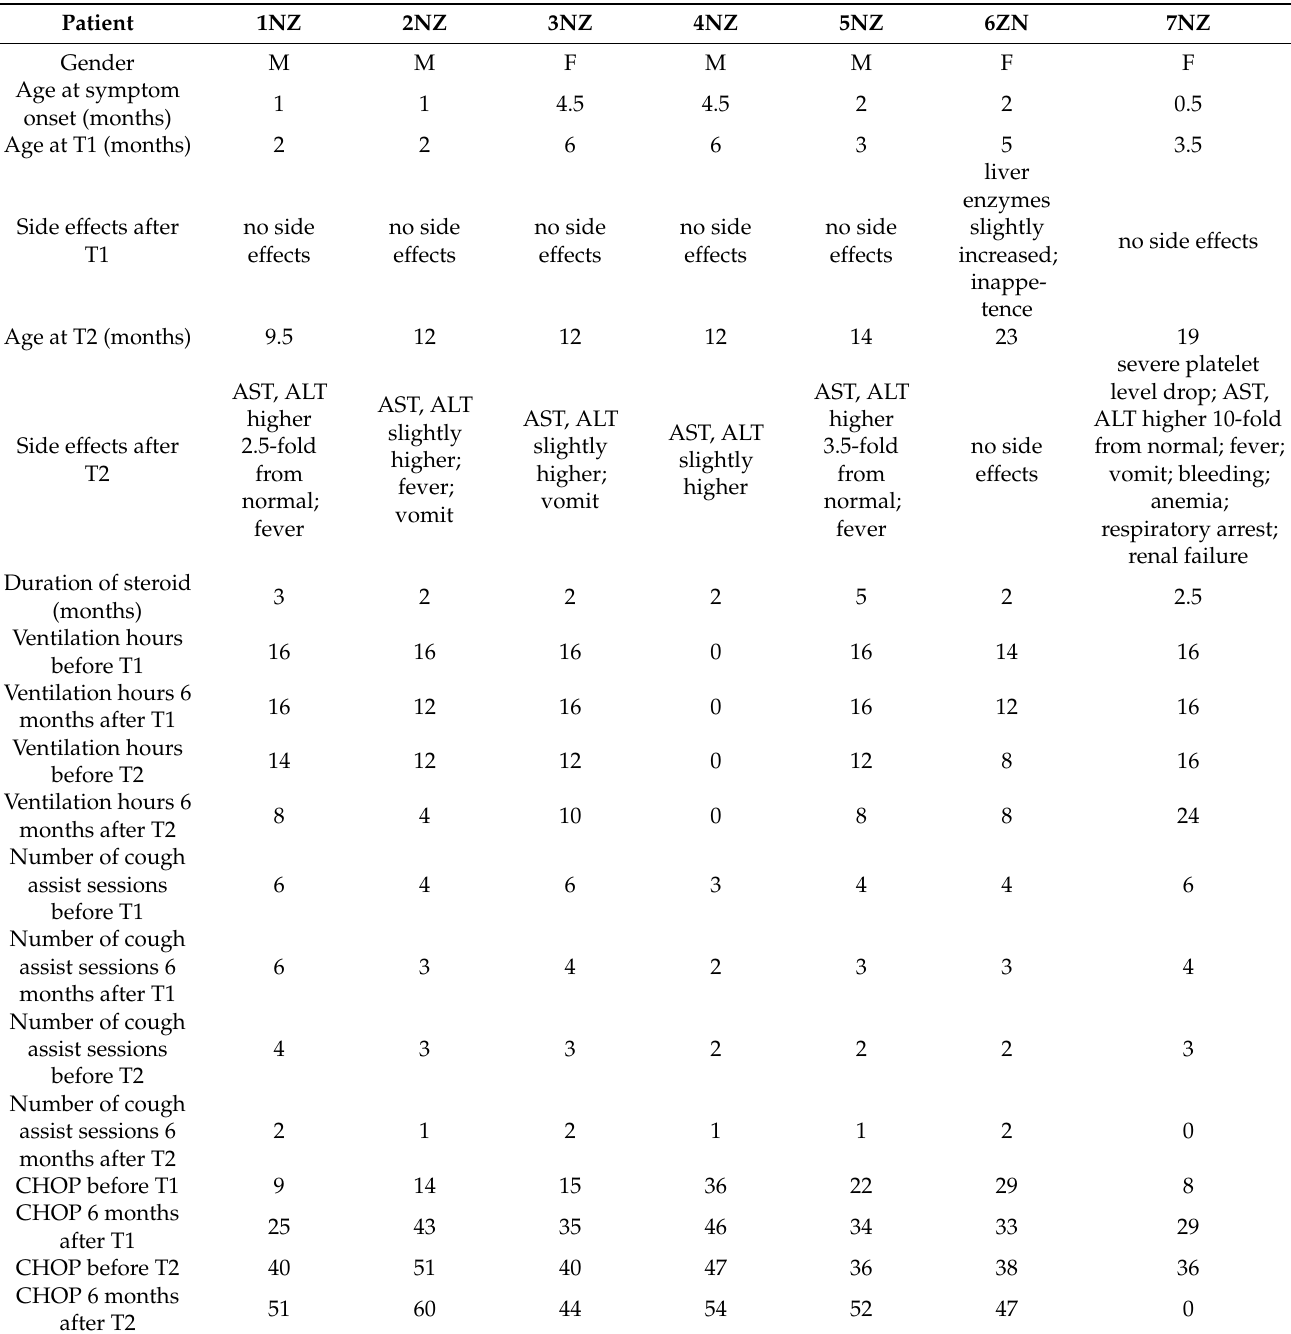
Table 1. Clinical and demographic information of study group